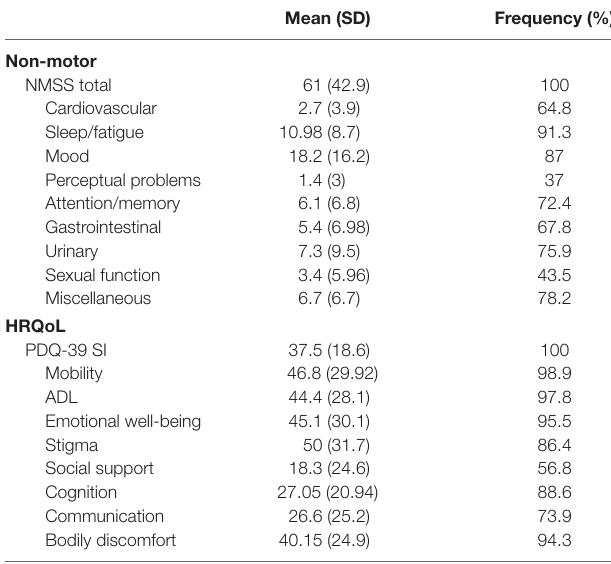
Table 2 | Non-motor and HRQoL characteristics of enrolled PD